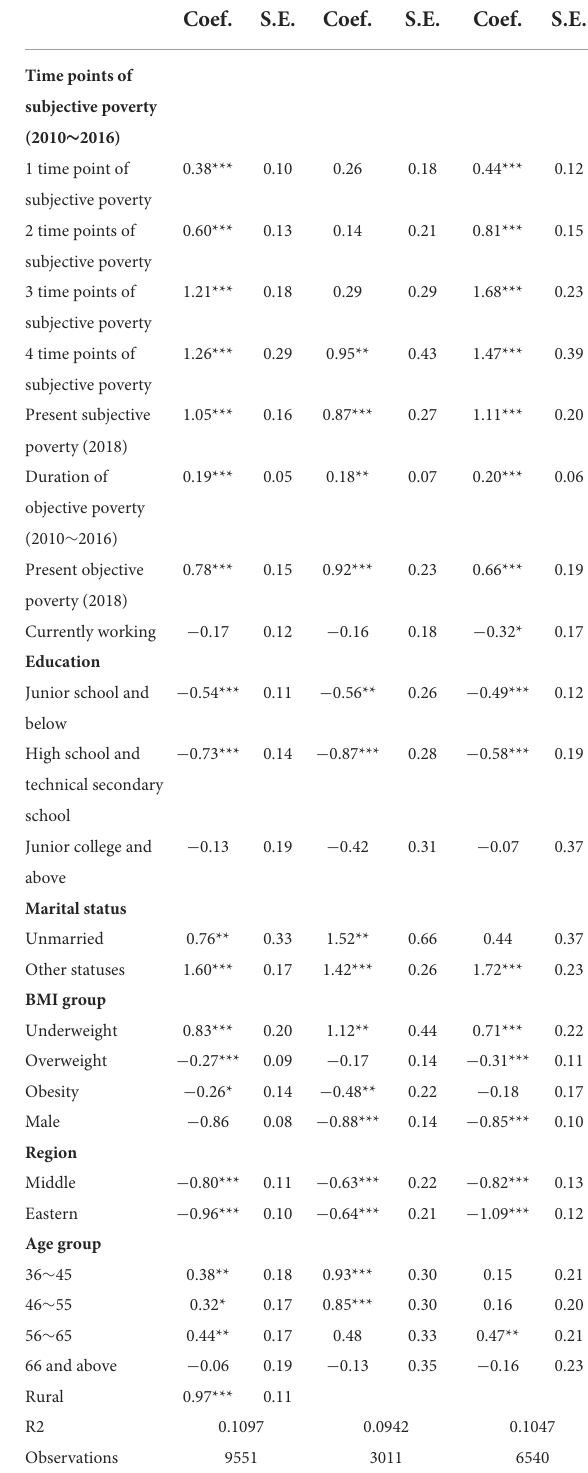
TABLE 8 Duration of subjective poverty and depressive symptoms in the rural sample. Model 1 Model 2